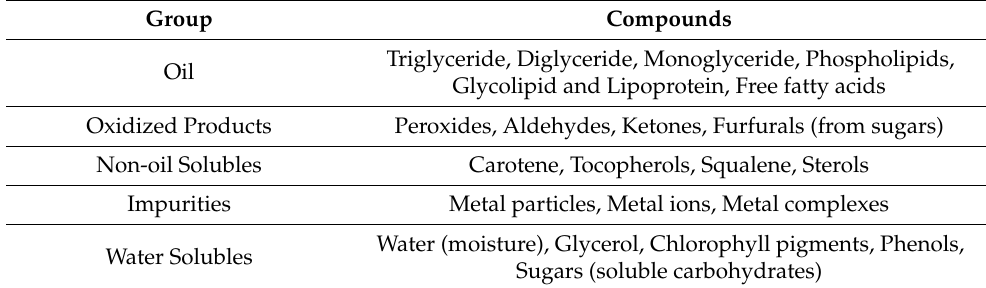
Table 1. Crude palm oil (CPO)